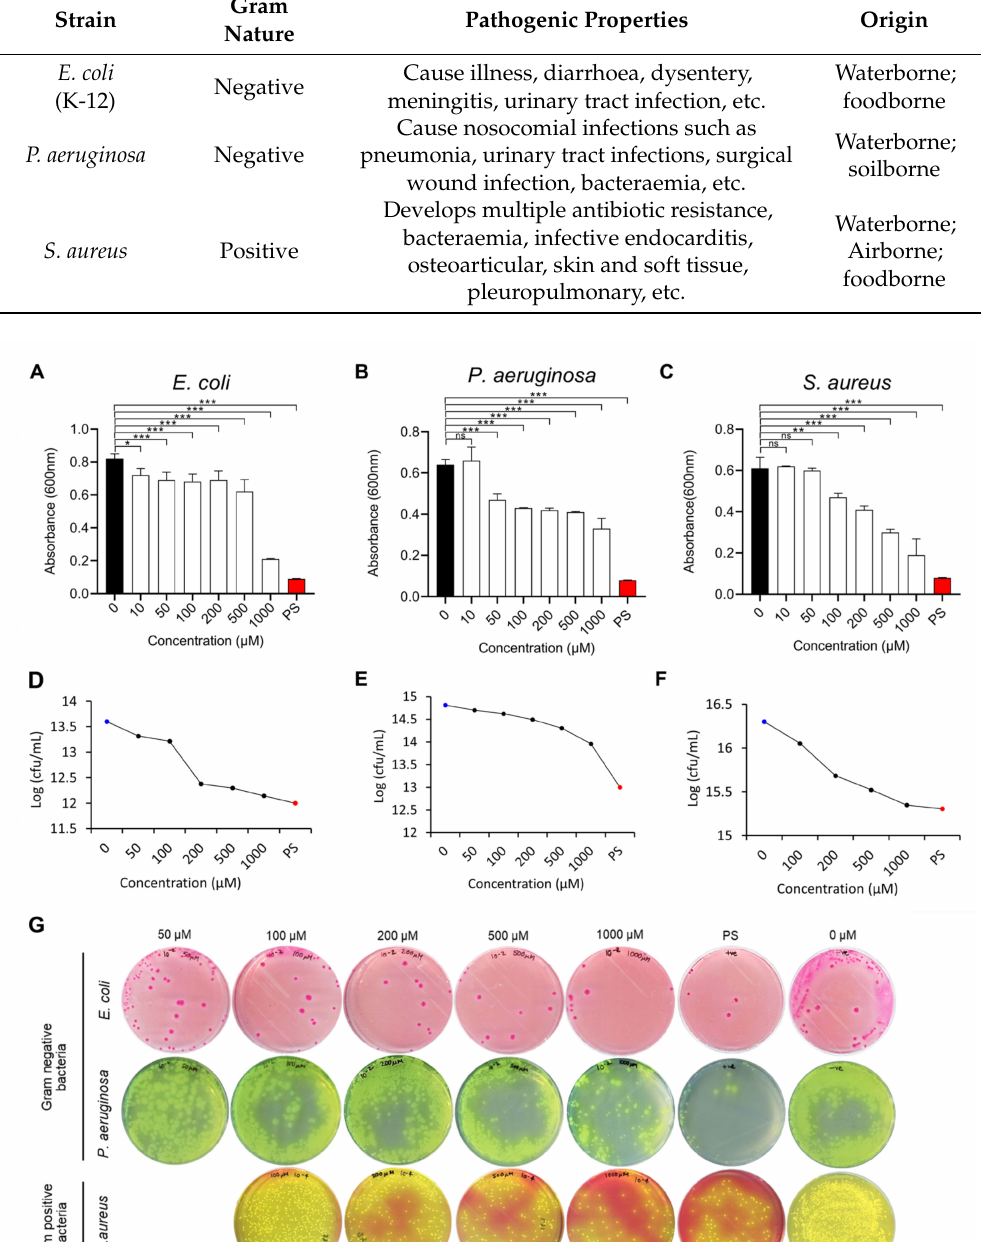
Table 1. Bacteria used in the study and their pathogenic properties.